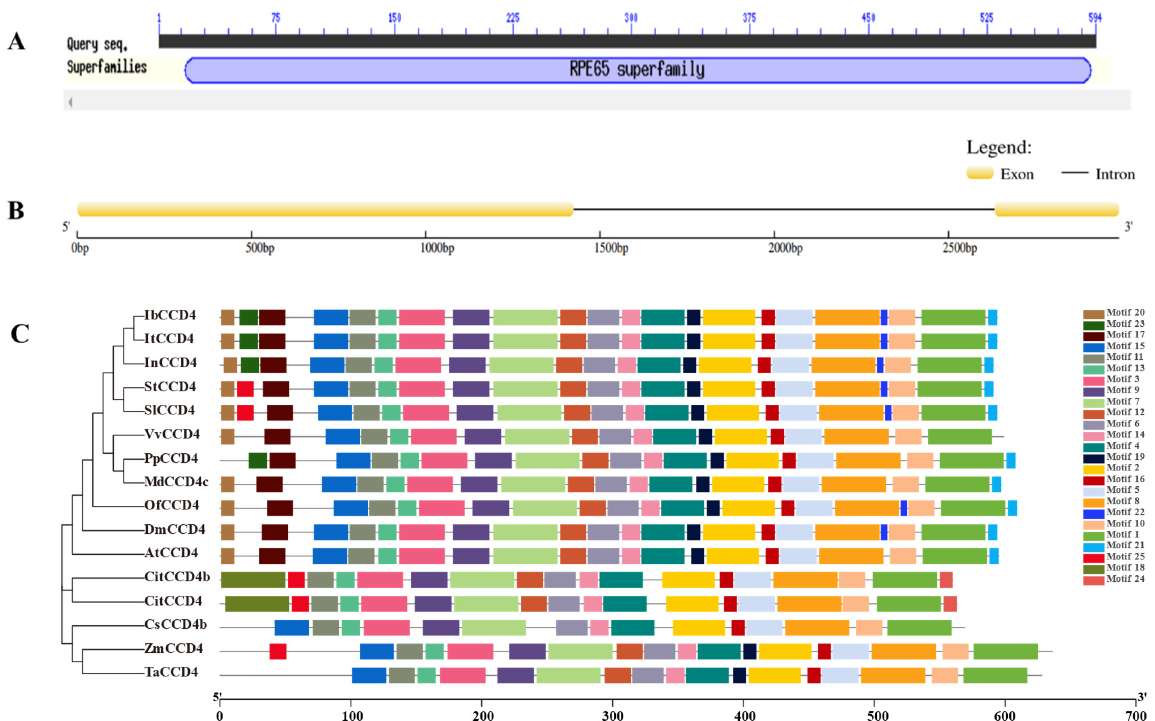
Figure 1. Bioinformatics analysis of IbCCD4 : ( A ) conserved domain of IbCCD4; ( B ) gene structural analysis of IbCCD4 ; ( C ) phylogenetic tree and conserved motifs of the CCD4 proteins from IbCCD4 and 15 other plant species. The phylogenetic tree is shown in the left panel. GenBank accession num- bers of the CCD4 proteins include IbCCD4 ( Ipomoea batatas, ), ItCCD4 ( Ipomoea triloba ,